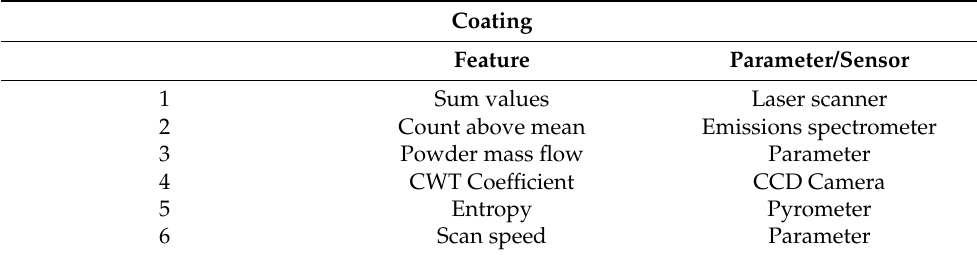
Table 3. Relevant features for coating